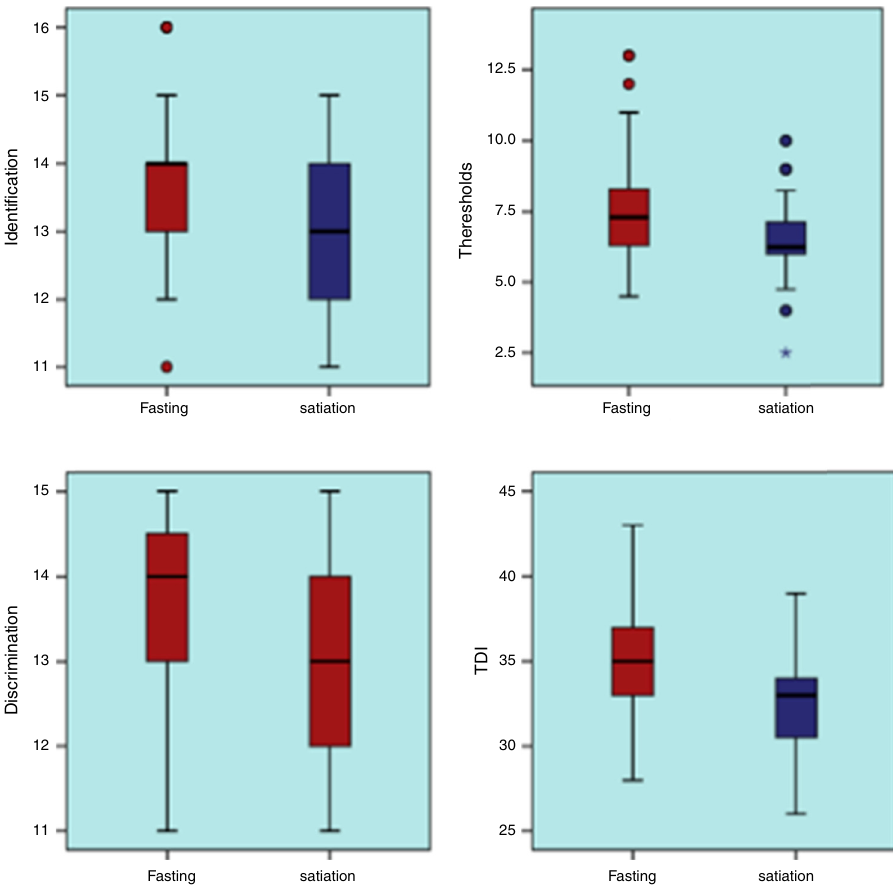
Figure 1 Overall olfactory function in hunger and in